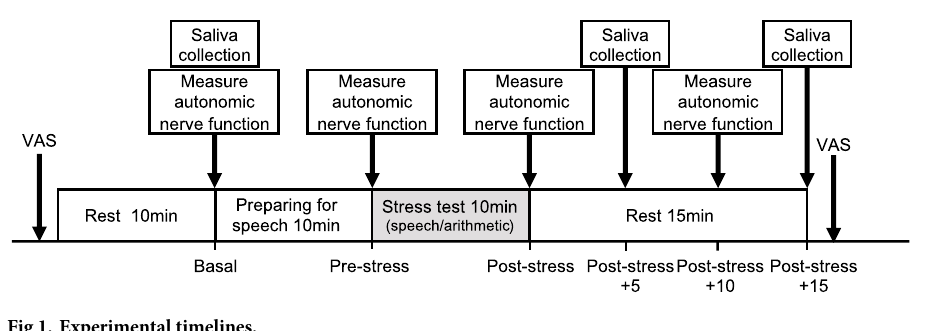
Fig 1. Experimental